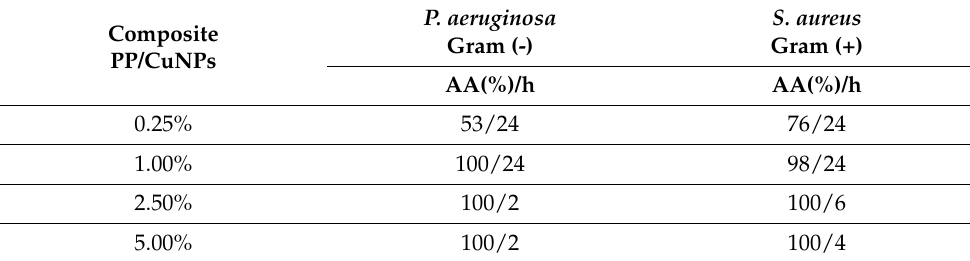
Table 2. Antibacterial activity (AA) of iPP/CuNPs composites toward. Composite PP/CuNPs